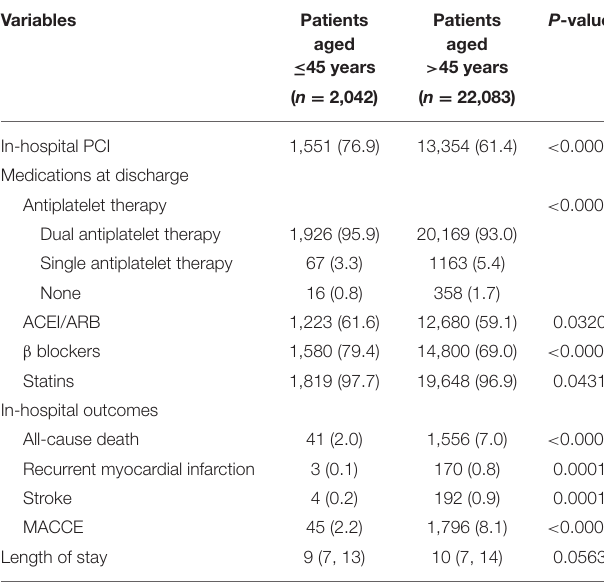
TABLE 3 | In-hospital management and outcomes of patients in different age